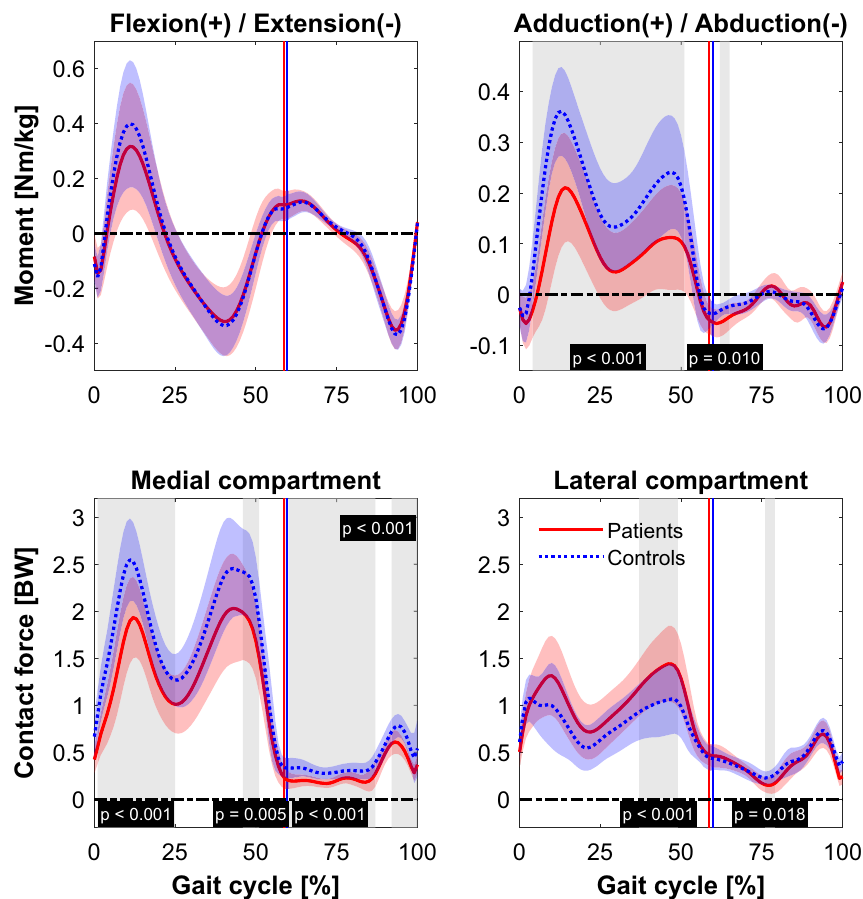
Figure 1. The mean (line) and standard deviation (shaded) of the external knee flexion and adduction moment and the medial and lateral knee contact force of the patients with valgus malalignment (red, solid) and the typically developed healthy controls (blue, dashed) are displayed. Vertical lines mark the end of the stance phase. Joint moments were normalized by body mass (unit: Nm/kg) and the joint contact forces by body weight (unit: BW). Significant different phases ( p < 0.05) during the gait cycle (normalized to 100%) calculated with a statistical parametric mapping two sample t -test are highlighted with gray areas and are described with the associated p -value (black